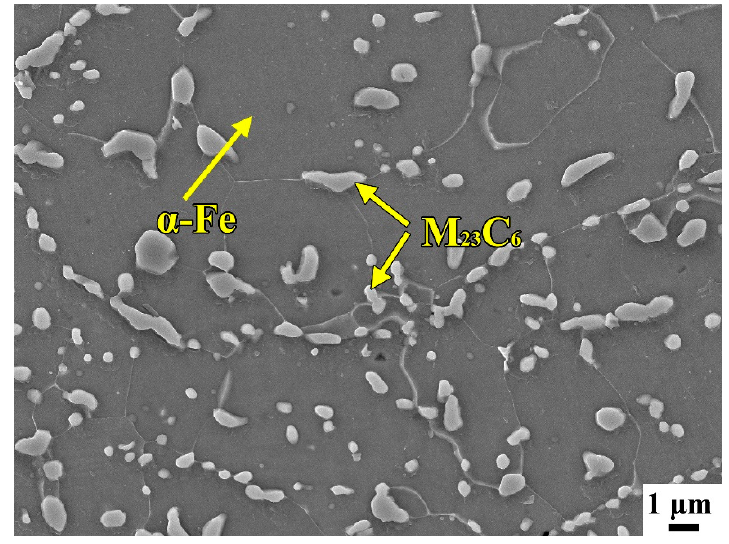
Figure 1. The microstructure image of the 2Cr13 steel substrate.